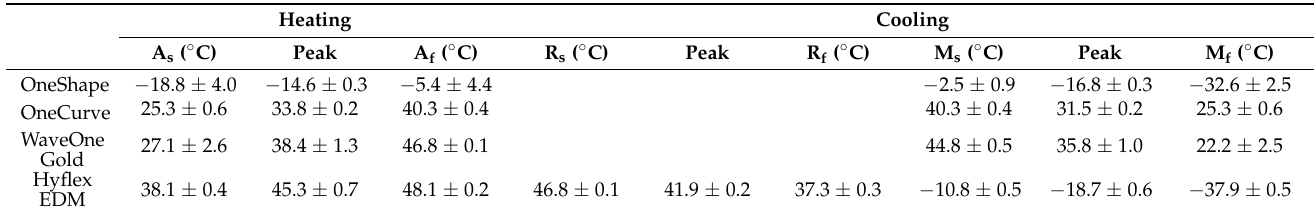
Table 3. Transformation temperatures for NiTi rotary instrument (mean ± SD, n = 5 for all instruments). Heating